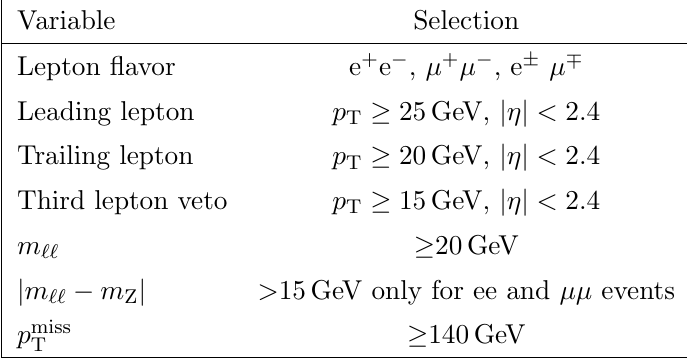
Table 1 . De(cid:12)nition of the baseline selection used in the searches for chargino and top squark pair